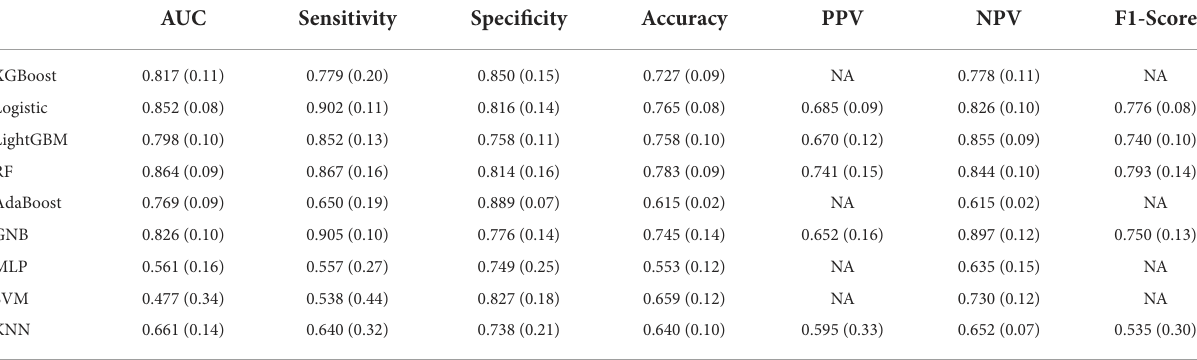
TABLE 4 Model parameters in validating set.